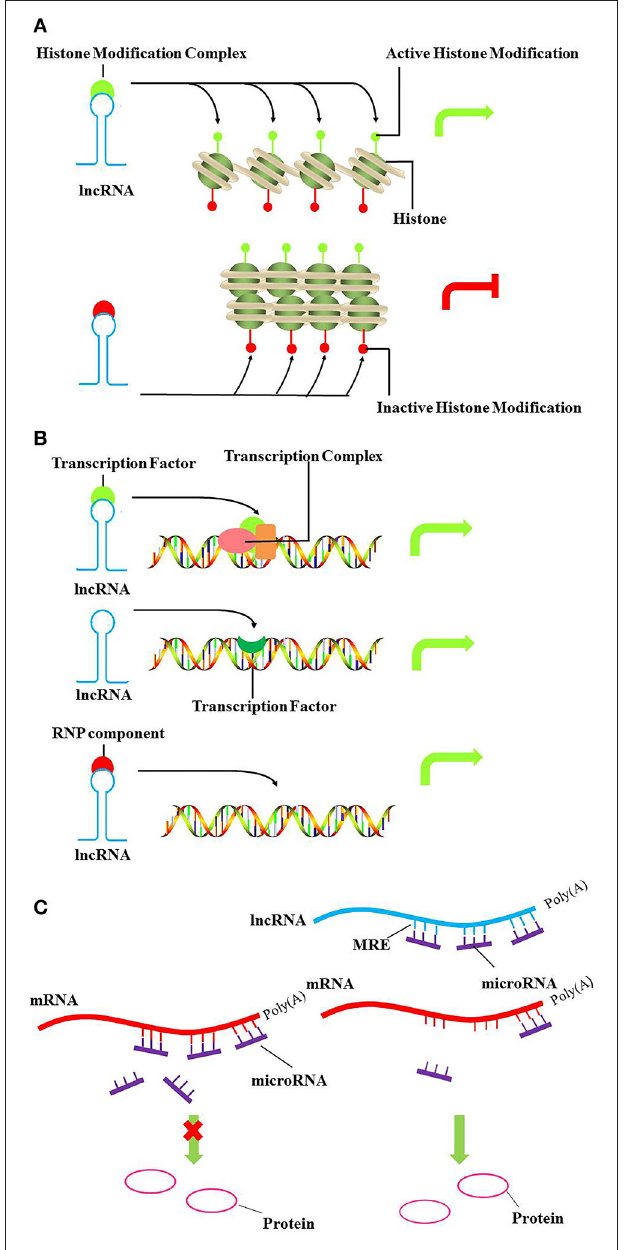
FIGURE 1 | Models of lncRNA mediated chromatin remodeling, transcriptional, and post-transcriptional regulation. (A) LncRNA can act as scaffold to recruit chromatin remodeling components, such as histone modifiers to specific genomic loci and reprogram the state of chromatin to silence or activate transcription. The upper panel and lower panel represent the active and inactive chromatin, respectively. (B) In the upper panel and lower panel, lncRNA can act as decoy or as a guide to bind transcription factors or ribonucleoproteins, altering recruitment to specific genomic loci in cis or in trans , ultimately driving transcription of the localized gene. As shown in the middle panel, lncRNA can also act as signal to regulate gene expression. (C) LncRNAs act as miRNA “sponges” by sharing common MREs, inhibiting normal miRNA targeting activity on mRNA. Green arrows, activate transcription; Red arrows, inhibit